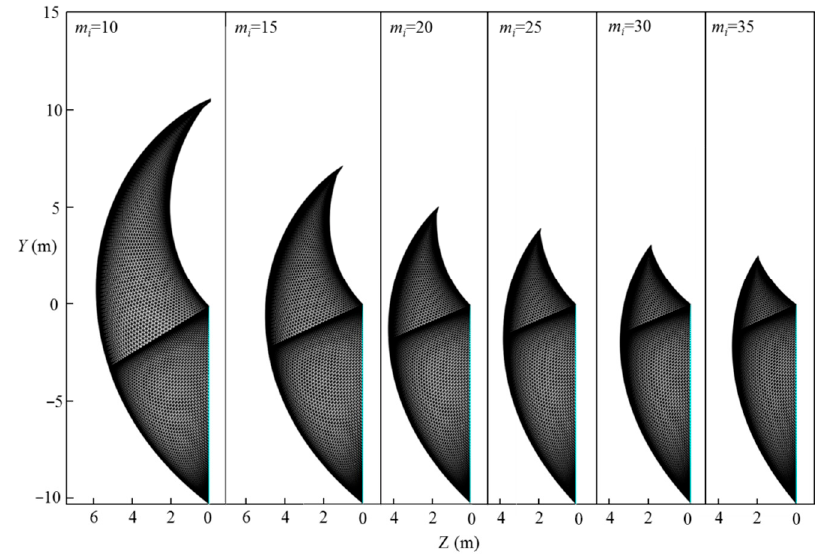
m on the 3D failure surface. Figure 11. Effect of m i on the 3D failure surface. i